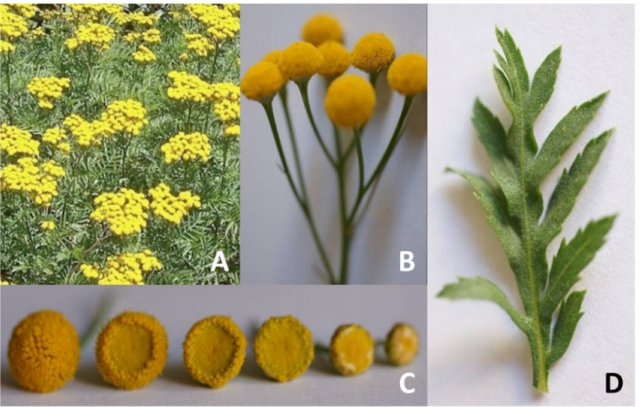
Figure 1. Tansy: ( A ) overview, ( B ) button-like flower, ( C ) different state of tansy anthodium, ( D ) finely divided compound leaf.